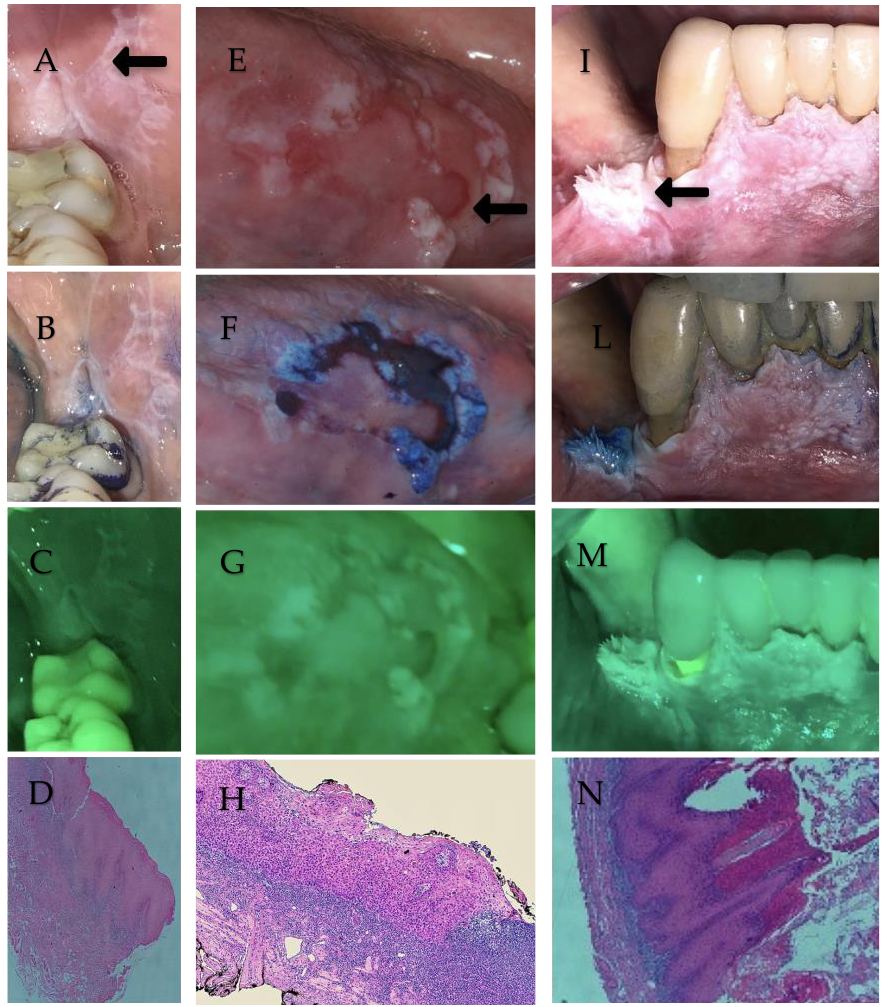
Figure 3. Clinical appearance, blue toluidine staining and autofluorescence analysis of three different lesions. Case 1 shows a lichenoid lesion in white light ( A ) considered non-suspicious at clinical examination, which was negative by blue toluidine staining ( B ) and autofluorescence visualization ( C ). The histopathologic analysis shows acanthosis, hyperparacheratosis, infiltrated lichenoid lymphocyte with vacuolization of the basal layer ( D ). Case 2 shows a suspicious red lesion ( E ), that was positive by blue toluidine staining ( F ) and autofluorescence visualization ( G ). Biopsy ( H ) revealed a condition of moderate dysplasia with areas of severe dysplasia. Case 3 shows a proliferative suspicious lesion ( I ) that was negative by blue toluidine staining ( L ) and autofluorescence visualizaion ( M ). The histopathologic diagnosis was a verrucous carcinoma ( N )